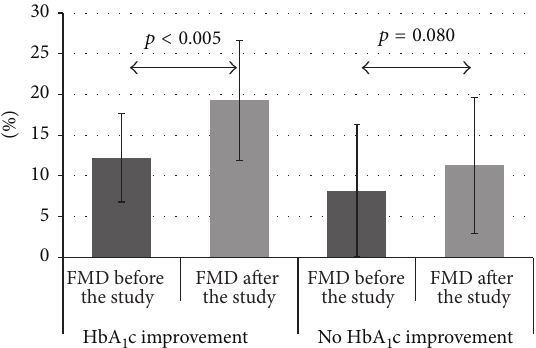
Figure 2: FMD changes depending on HbA 1 c improvement in follow-up (data presented as mean ±